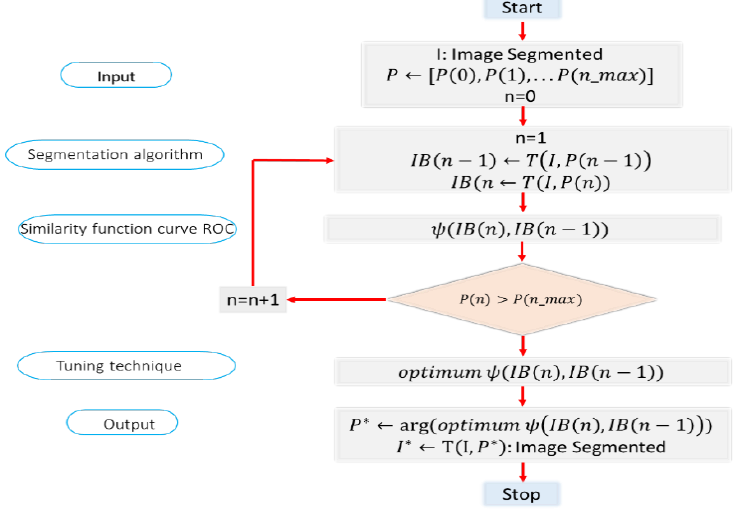
Figure 6. Flowchart of the tuning technique.